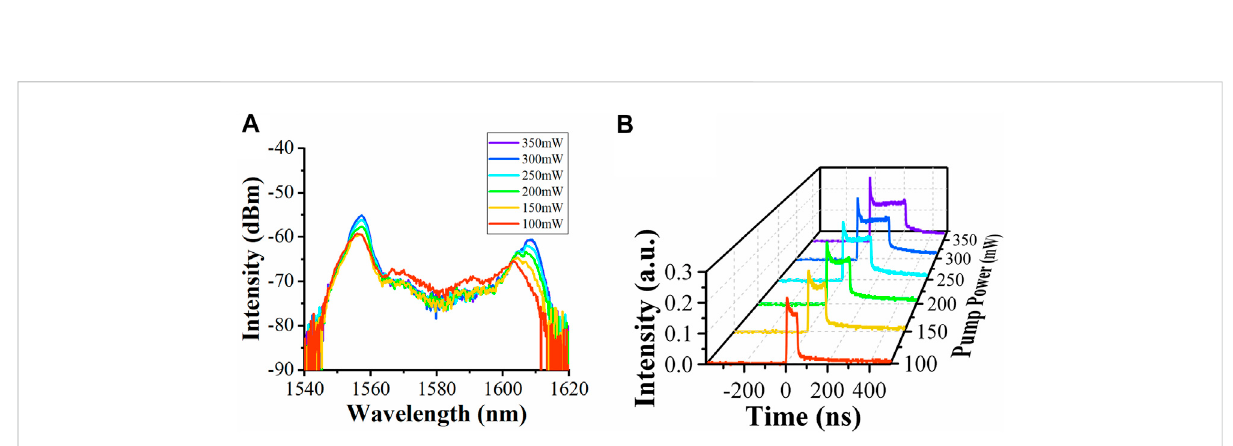
FIGURE 6 (A) The variations of the output spectra under different pump powers after adjusting the PCs. (B) Corresponding temporal pulse pro fi le as increasing pump